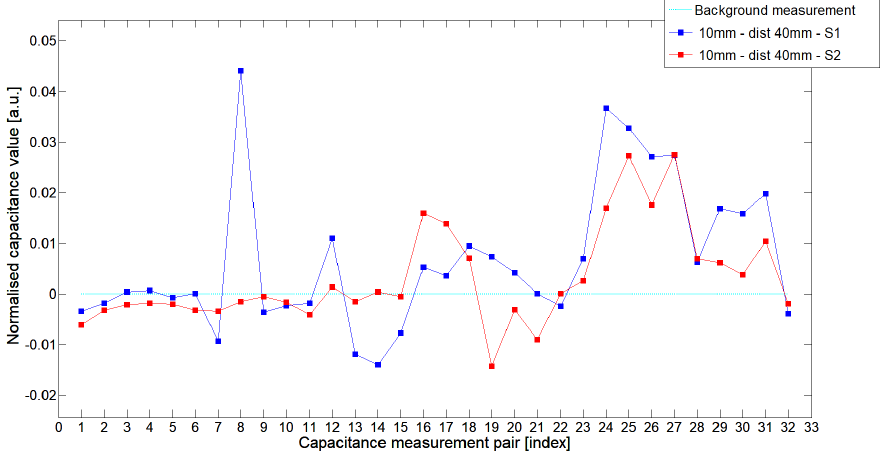
Figure 22. The 1st electrode measurement cycle (S1: 1->32 and S2: 1->32) for Test10 P 2 and S1—blue line, S2—red line. Cyan line indicates lower calibration